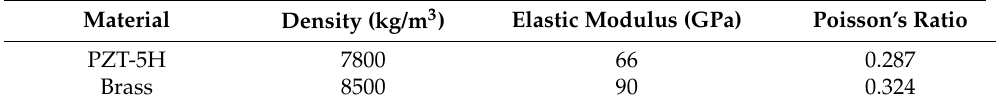
Table 1. Material